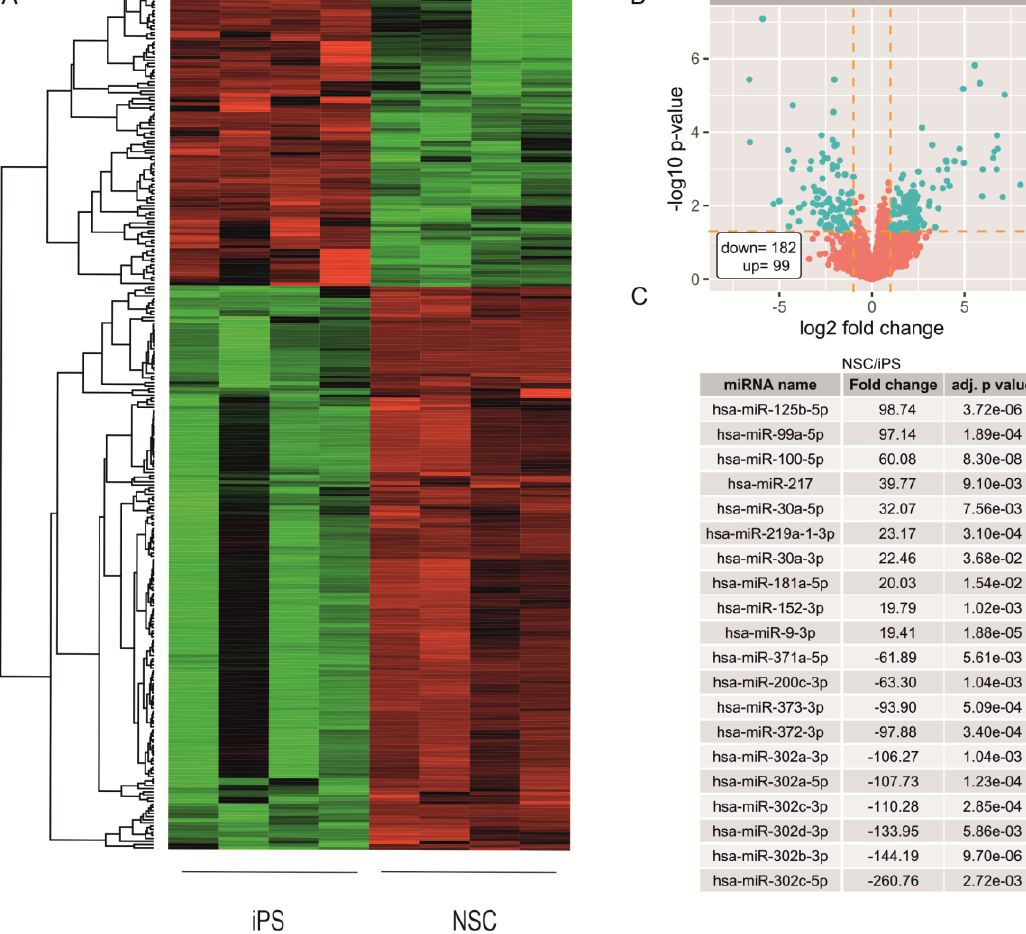
Figure 2. Microarray data analysis revealed a profile of miRNAs differentially expressed between iPSC and derived from them NSC cell lines ( A ). Volcano plot show the total miRNA expression profile of the iPSC and NSC cell lines. MiRNAs above the cut off are considered to be differentially expressed and are shown as blue dots ( B ). The table shows 20 miRNAs with the highest (10 miRNAs) and lowest (10 miRNAs) fold changes obtained from the differentially expressed miRNAs list ( C ).